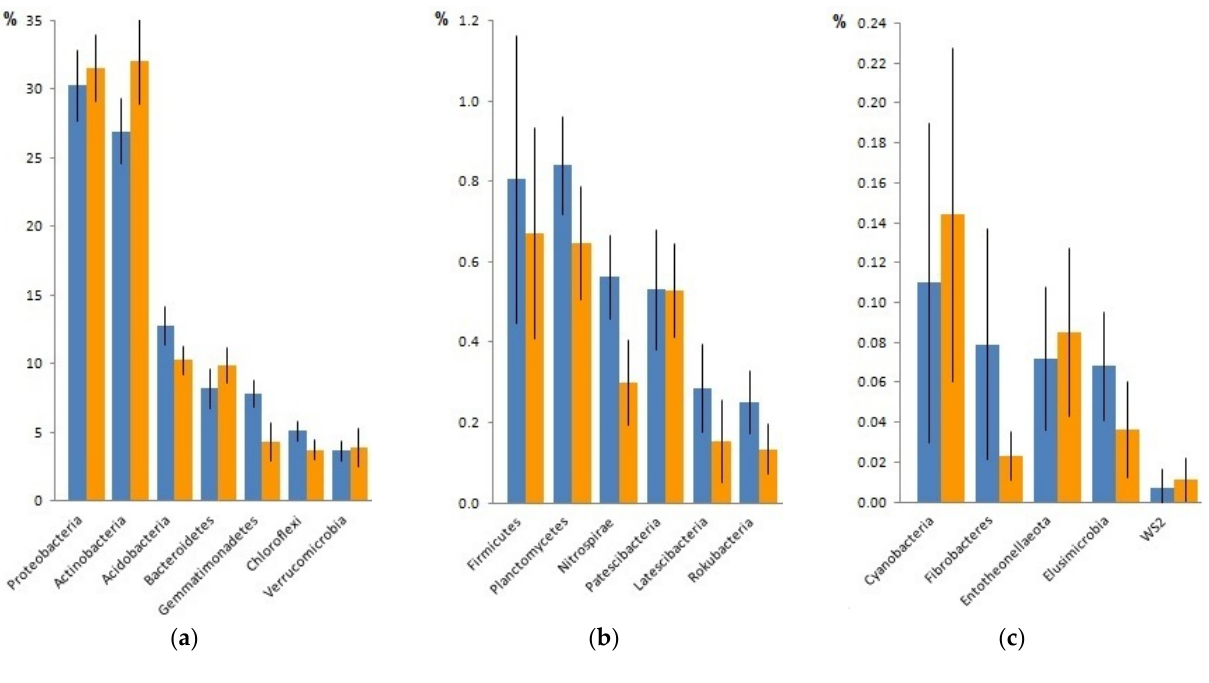
Figure 4. Taxonomical structure of chernozem bacterial communities on the level of phyla, ( a – c ) include different phyla and differ in scale. Blue bars represent arable soils, orange represent non-arable. Confidence intervals at 95% showed as error bars were calculated for n = 10.